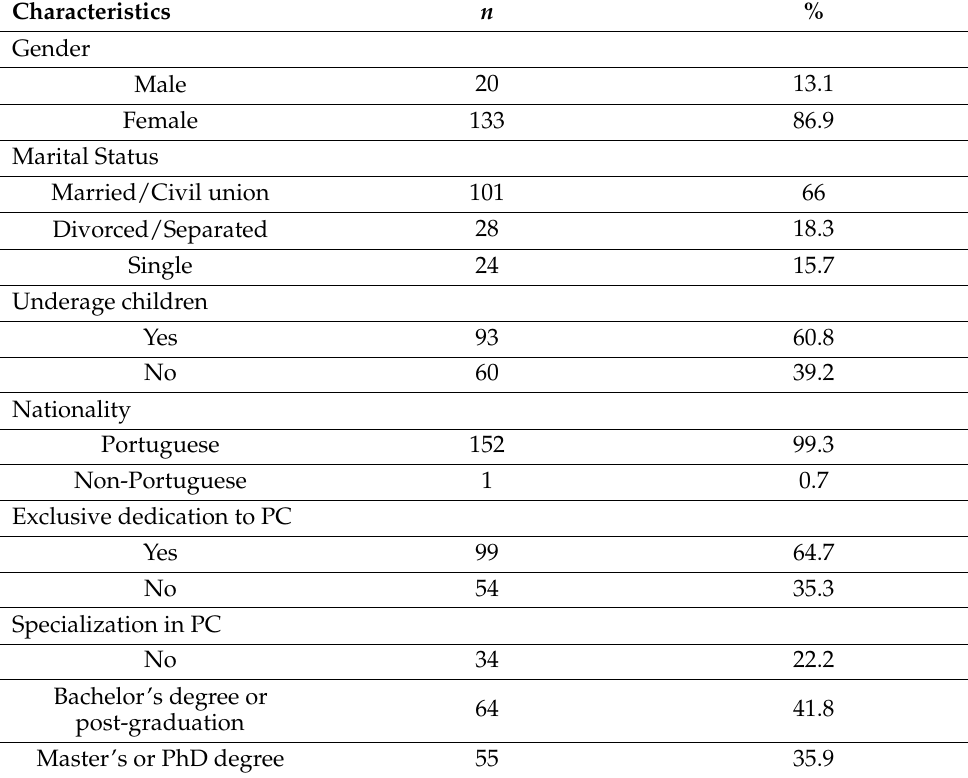
Table A1. Sample characterization ( n =